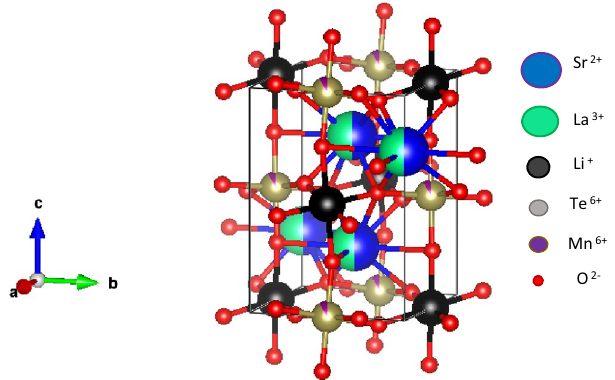
Figure 2. Image of refined XRD in SrLaLiTe 1− x Mn x O 6 from bc plane.